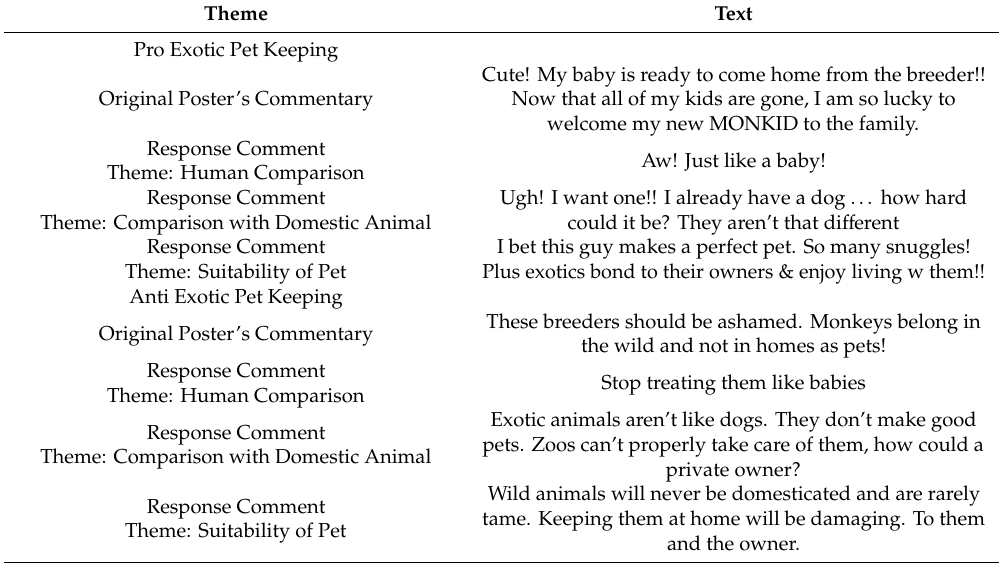
Figure 1. Comparison of two fictional Facebook groups, the ‘Anti-Low’ condition and the ‘Pro-High’ condition. Note that the ‘Anti-High’ condition is identical to the ‘Anti-Low’, aside from the number of reactions, and vice versa for ‘Pro-Low’ and ‘Pro-High’. Table 2. Pro and anti narrative commentary and social network response comparison.